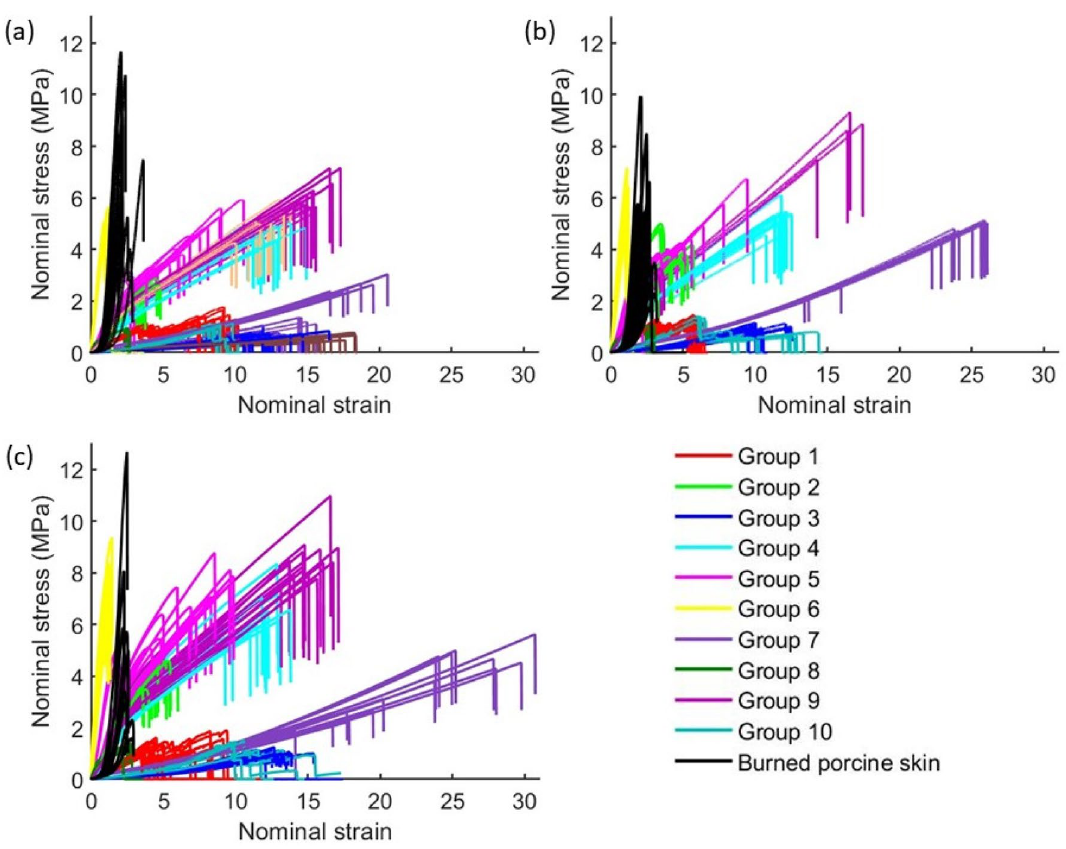
Figure 1. Nominal stress–strain curves of synthetic tissue samples and full thickness burned porcine skin tissue samples loaded at ( a ) 0.3 mm/s, ( b ) 2 mm/s, and ( c ) 8 mm/s. Curves are shown until the rupture